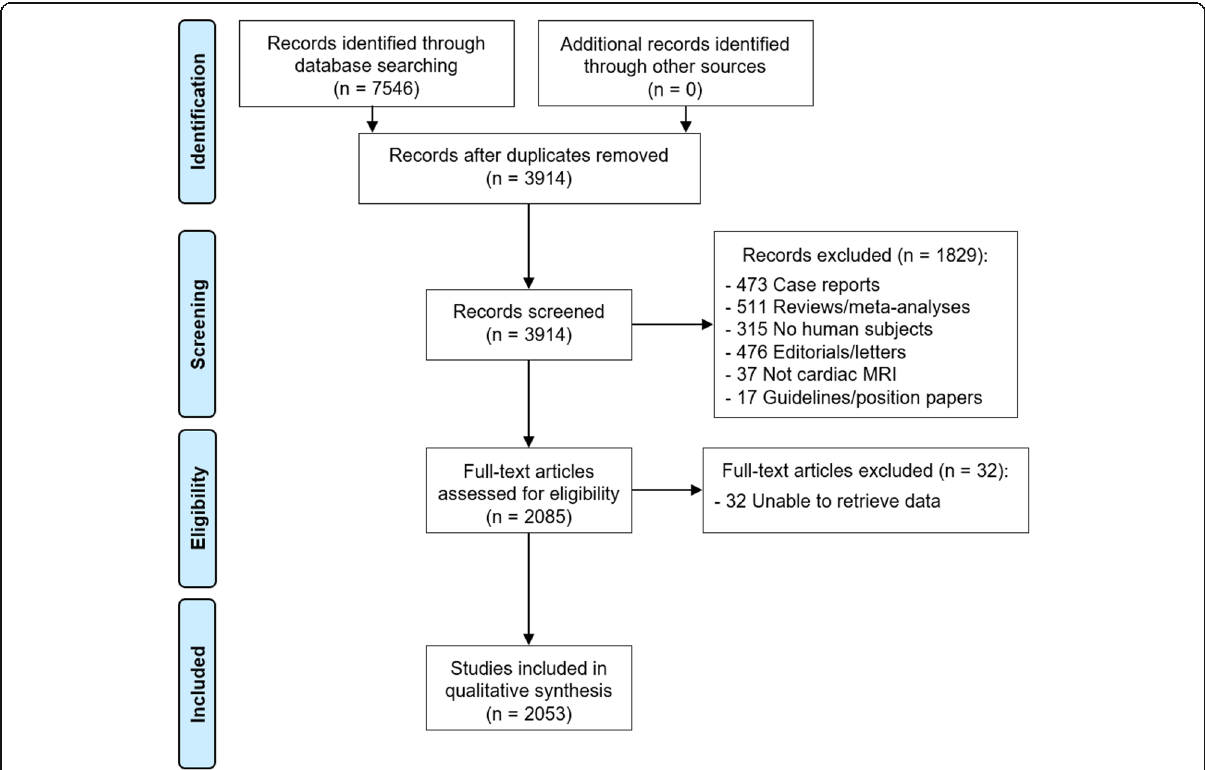
Fig. 1 Literature review and study selection process flowchart